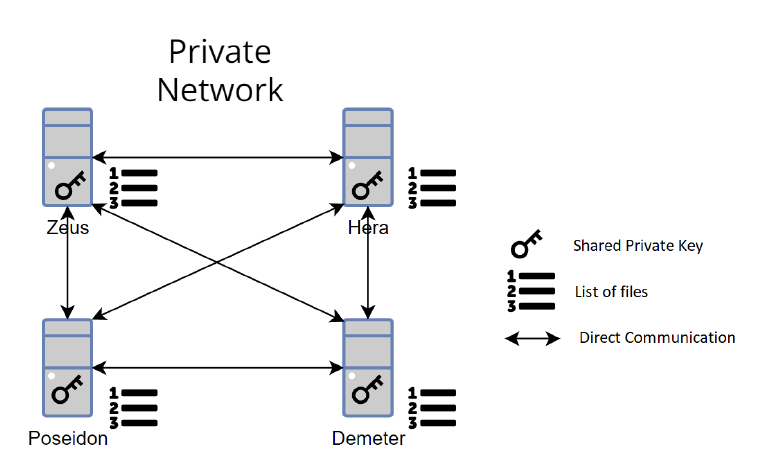
Figure 1. Olympus: HLF Network.